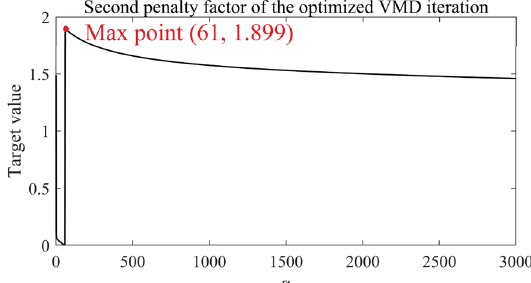
Figure 19 Second penalty factor of the optimized VMD iteration